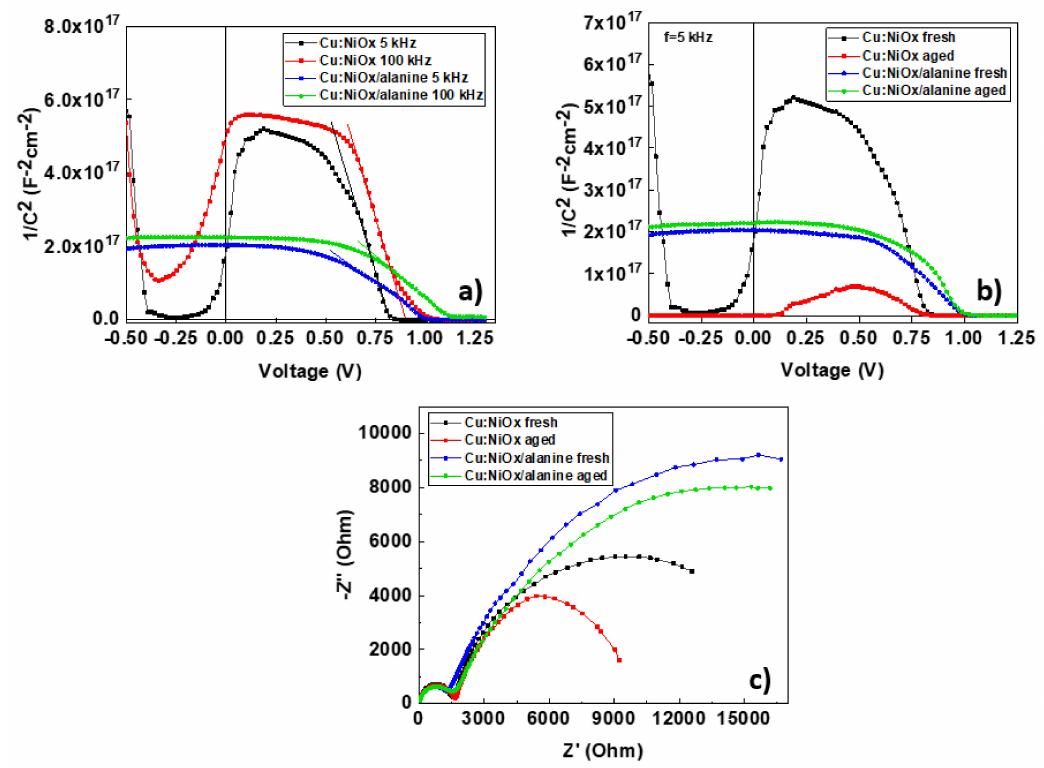
Figure 6. Mott–Schottky plots of ( a ) untreated and β -alanine-treated Cu:NiOx-based devices in 5 and 100 kHz, ( b ) fresh and aged untreated an β -alanine-treated Cu:NiOx-based devices at 5 kHz, and ( c ) Nyquist plots fresh an aged untreated and β -alanine-treated Cu:NiOx-based